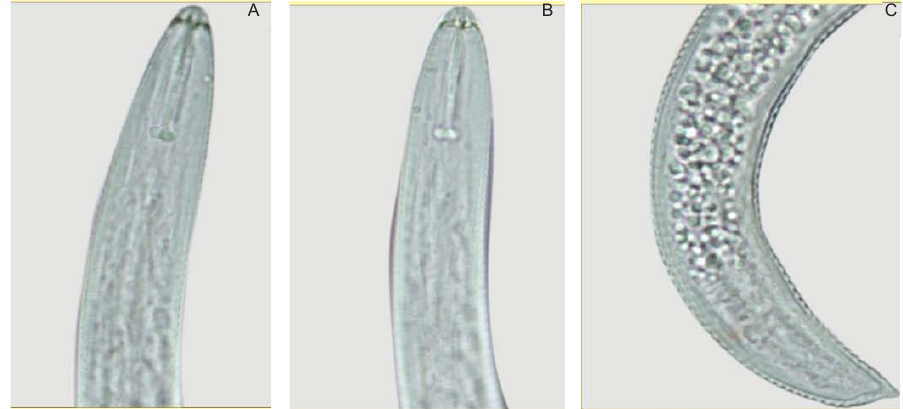
Image 2. Helicotylenchus californicus Sher, 1966. A - Anterior end; B - Basal Knobs; C - Posterior